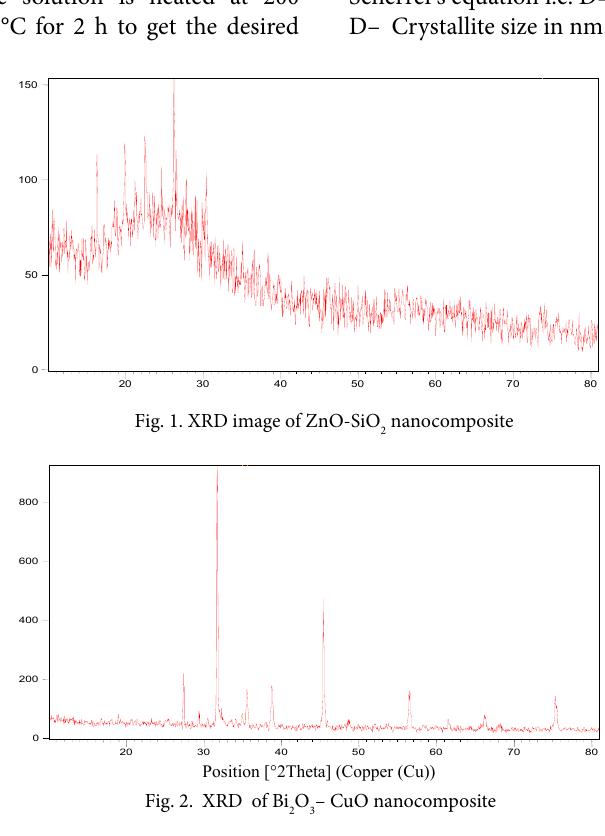
Fig 1. XRD image of ZnO - SiO 2 nano composite.